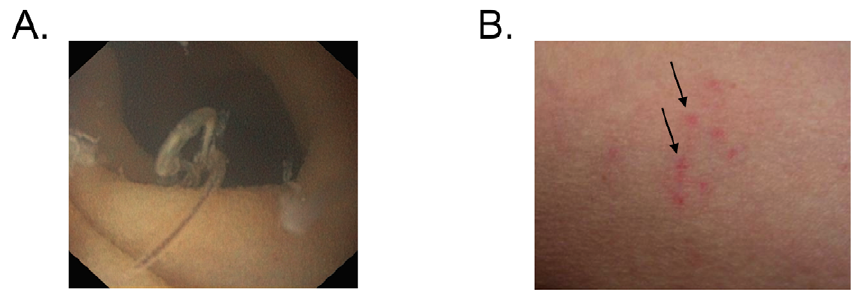
Figure 3. Representative photographs of parasitic infection (A) Adult hookworm (B) Inoculation site.